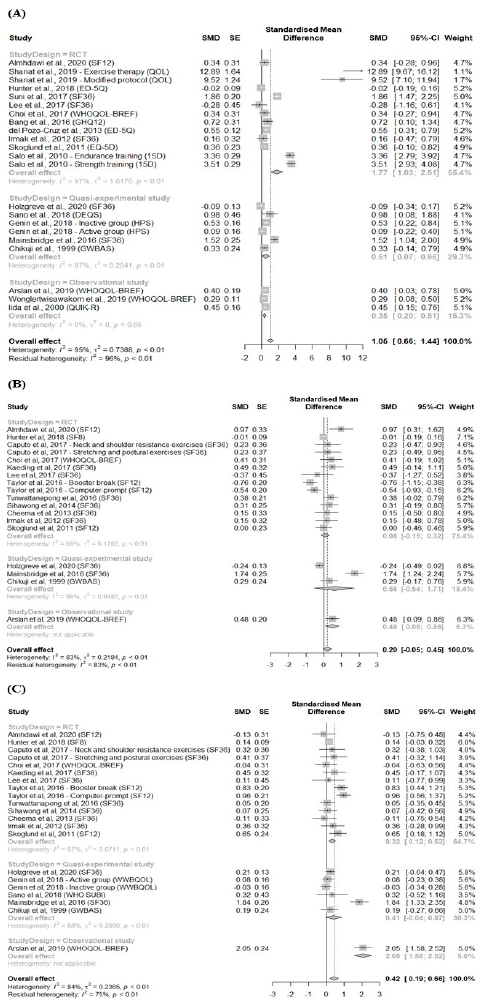
Figure 2. Meta-analyses of the effects of physical exercise on three HRQOL domains in office workers. ( A ) General; ( B ) physical; and ( C ) mental. HRQOL = health-related quality of life; SMD = standardized mean difference; SE = standard error; CI = confidence